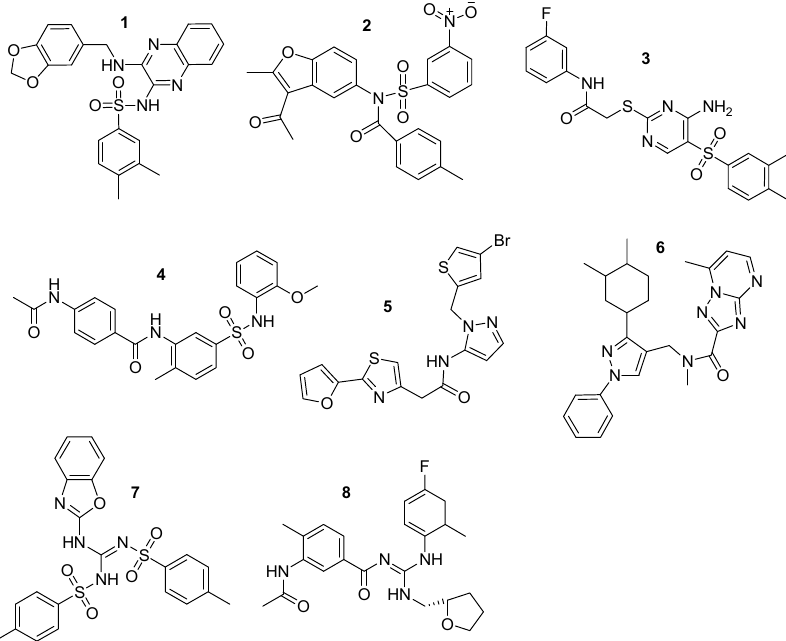
Figure 6. Final compound selection from the pharmacophore-based virtual screening (VS) and the docking studies. Zinc IDs: 1 : ZINC02414861, 2 : ZINC08765786, 3 : ZINC09152123, 4 : ZINC09517045, 5 :